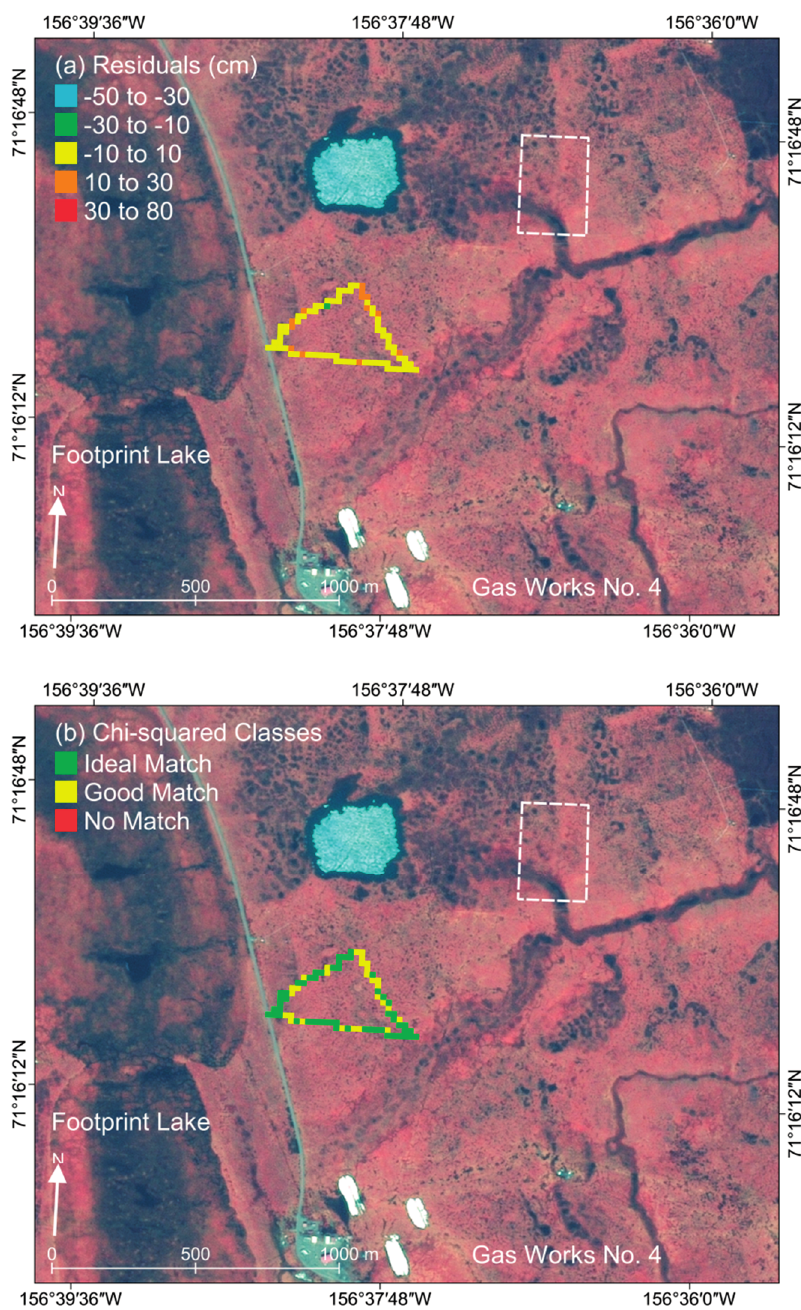
Figure 5. Residuals ( a ) and χ 2 classes ( b ) between the GPR ALT and ReSALT at the Central Plain Site. The Central Plain site consisted of high-center polygons typical of undisturbed tundra around Barrow and well represented in the idealized ReSALT retrieval algorithm; The white square in (a) indicates where Gangodagamage et al. [13] estimated ALT using